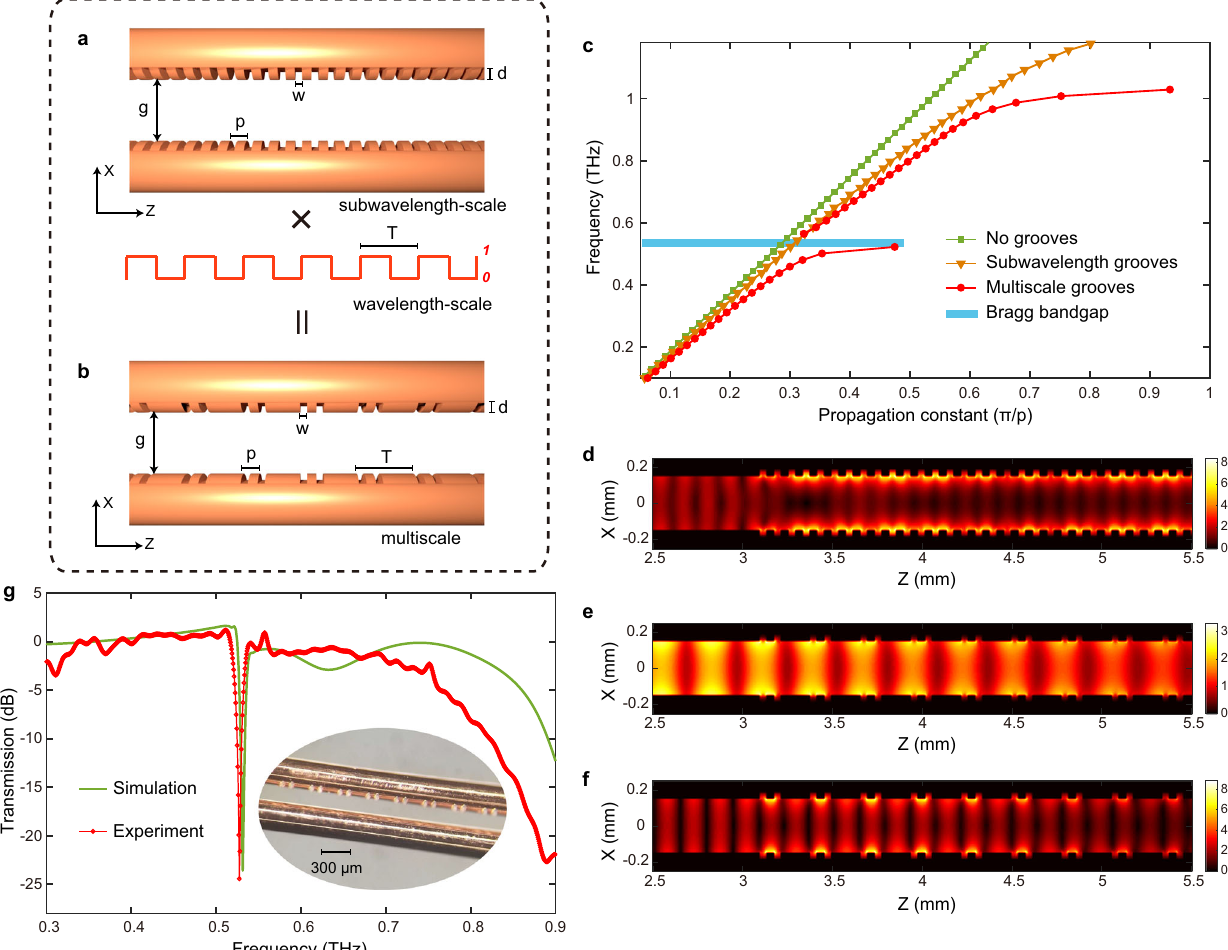
Fig. 1 Direct engraving of Bragg gratings on metal-wires. Based on a two-wire waveguide (TWWG) geometry (with a wire radius r = 127 µ m and an air gap g = 300 µ m), Bragg gratings are realized by directly engraving grooves with multiscale structures (150-periods-long) along the metal-wires. a Schematic of the TWWG with sub- λ periodic grooves. Geometry of the grooves: width w = 35 µ m, depth d = 40 µ m, and period p = 80 µ m. b Schematic of the TWWG with multiscale grooves. This structure is achieved by superimposing a wavelength-scale periodic modulation with period T = 280 µ m onto the sub- λ periodic grooves shown in ( a ). c Simulated dispersion relations for the plain TWWG (no grooves) and the TWWGs with sub- λ and multiscale grooves. d Simulated electric fi eld modulus distributions, evaluated at 1.2 THz, in the TWWG with sub- λ grooves, showing that the THz energy is mainly trapped within the grooves, preventing further propagation. Simulated electric fi eld modulus distributions in the TWWG with multiscale grooves evaluated at 0.53 THz ( e ) and at 1.0 THz ( f ), respectively. g Simulated and experimental transmission spectra of the TWWG with the integrated Bragg gratings. The experimental result is obtained via a standard THz time-domain spectroscopy (TDS) system. The transmission spectra are achieved by calculating the ratio between the power spectra of the signals propagating through the TWWGs with and without grooves. The inset shows the optical microscopic image of the Bragg gratings directly etched on one of the two